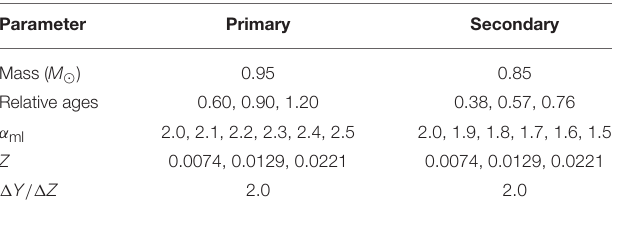
TABLE 1 | Summary of the simulation parameters for the considered synthetic binary systems.